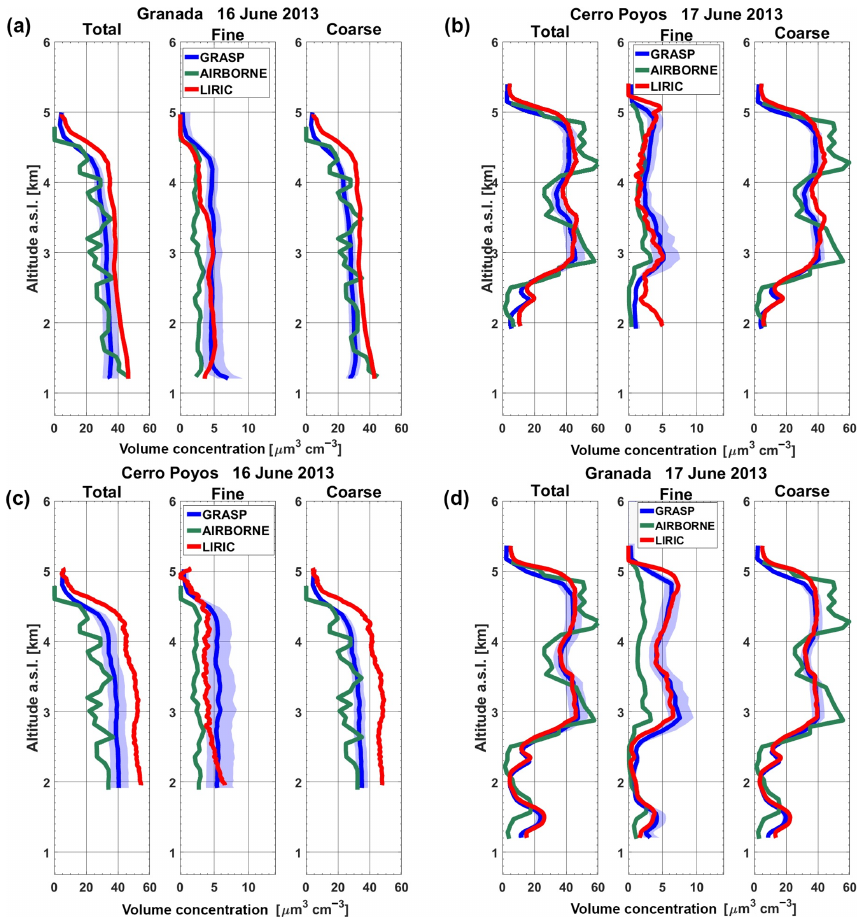
Figure 6. Volume concentration profile (total, fine and coarse mode) retrieved by GRASP (blue) with its uncertainty (shaded area), aircraft measurements (green) and LIRIC (red) on 16 (a, b) and 17 (c, d) June 2013 at Granada (a, c) and Cerro Poyos (b, d)